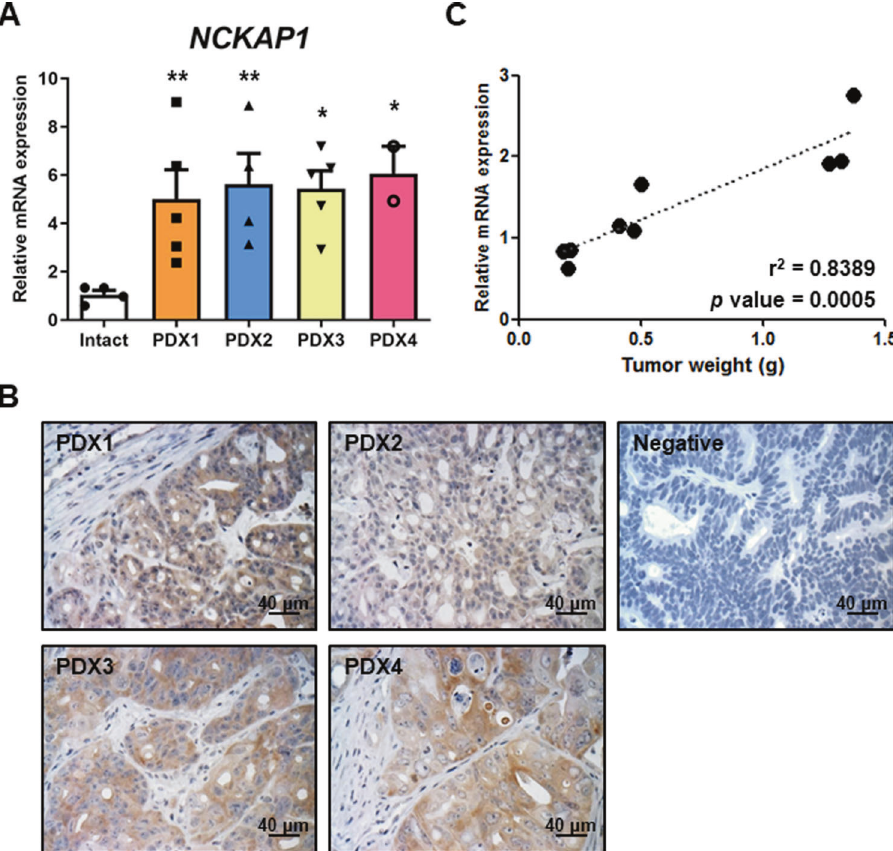
Fig. 1 Correlation of NCKAP1 expression level and CRC. A The mRNA levels of NCKAP1 were con fi rmed by qRT-PCR analysis in blood cells derived from four colon cancer PDX models. Data are reported as the mean ± SEM. Student ’ s t-test * p < 0.05, ** p < 0.01 vs. Intact. (Intact: n = 4, PDX1 : n = 5, PDX2: n = 4, PDX3: n = 5, PDX4: n = 2). B IHC staining was performed with anti-NCKAP1. Bar, 40 μ m. C Linear regression analysis was subsequently performed between relative mRNA levels of NCKAP1 and tumor weights. Data are reported as the mean ± SEM. Student ’ s t-test. p = 0.0005. ( n =